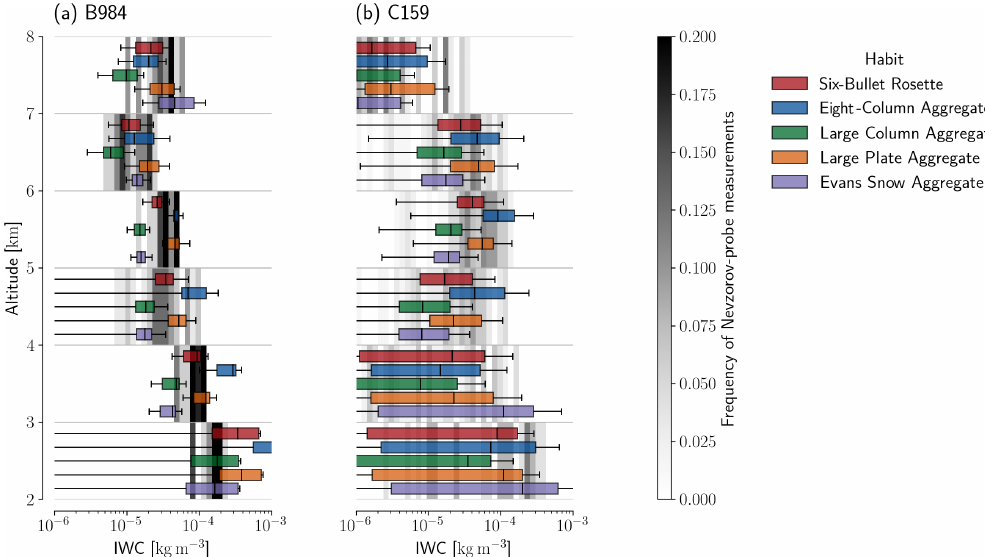
Figure 9. Comparison of bulk IWC as measured by the Nevzorov probe and inferred from in situ-measured PSDs using a given particle shape. The background in each plot shows the distribution of Nevzorov-measured IWC for a given 1km altitude bin. Colored boxes display the distribution of IWC in that bin inferred for a given particle shape. Boxes, whiskers and outliers are drawn following Tukey’s conventions for box